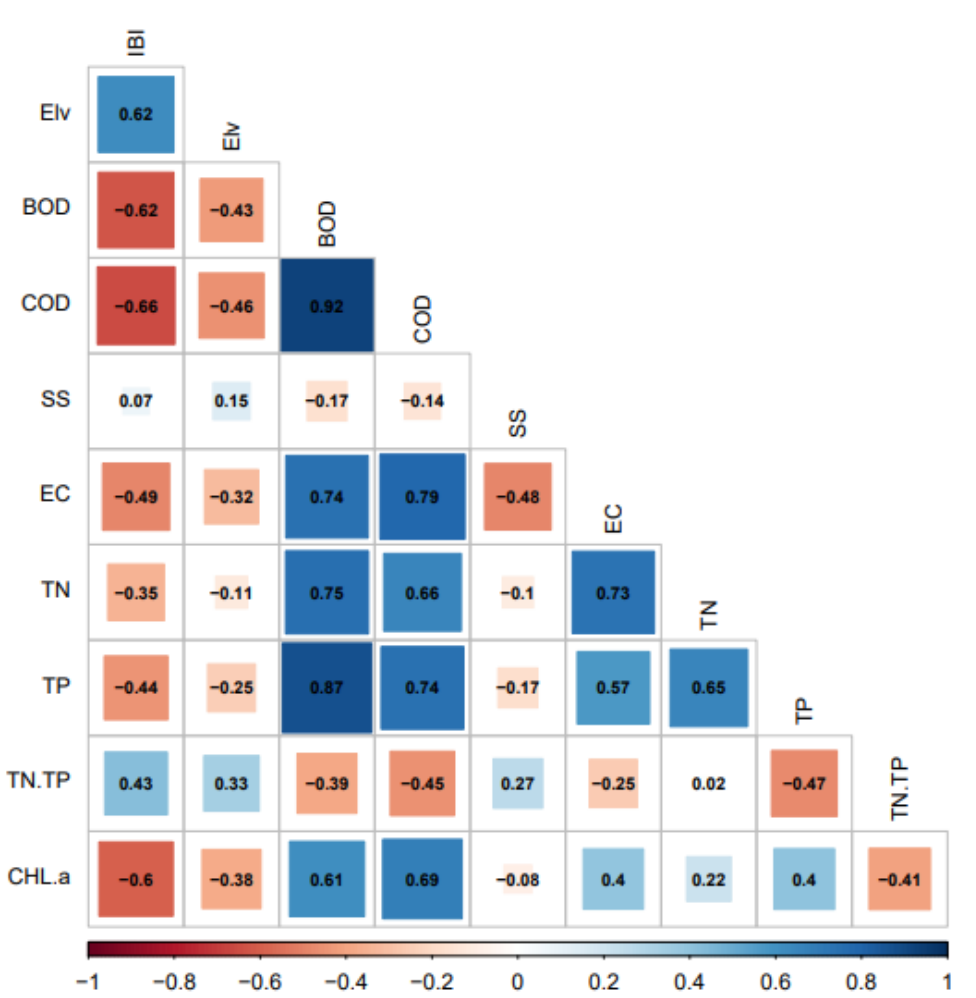
Figure 8. Correlation analyses among index of biotic integrity (IBI), water chemistry variables, and elevation (m) in 64 streams from four different land-use patterns (ranging from −1 to 1). The water chemistry parameters include biological oxygen demand (BOD), chemical oxygen demand (COD), total suspended solids (SS), electric conductivity (EC), total nitrogen (TN), total phosphate (TP), and chlorophyll-a (CHL-a).